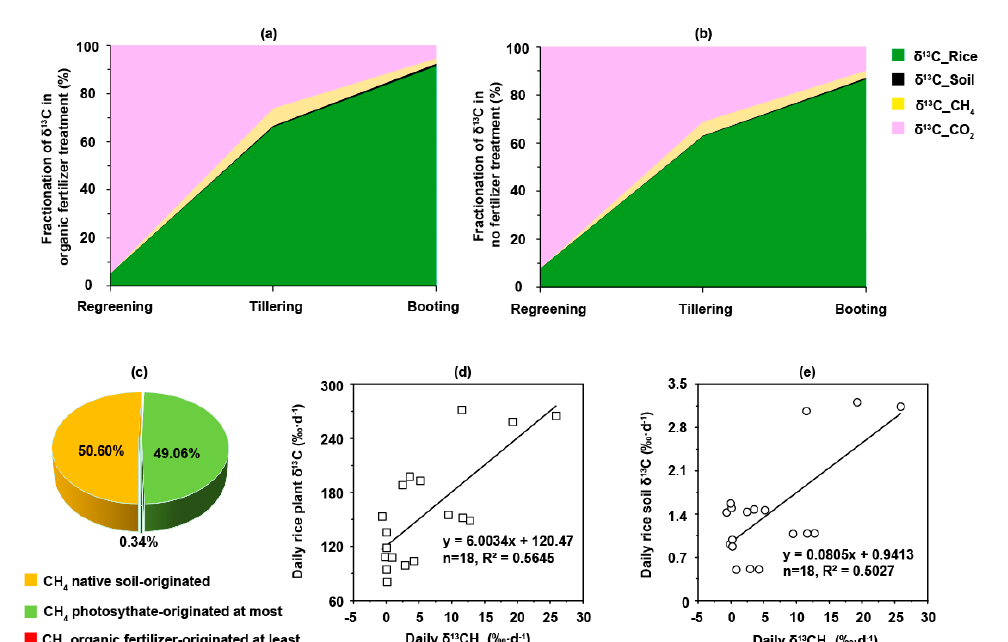
Figure 2. Relative abundance of δ 13 C from cultured rice soil. ( a , b ) are the distributions of δ 13 C in the CO 2 , CH 4 , rice plant and soil for the average values of organic fertilizer and no fertilizer treatment. ( c ) shows the total carbon sources for the CH 4 emissions in the cultivated rice soil. ( d , e ) are the linear regressions for the daily δ 13 CH 4 to the daily rice plant δ 13 C and soil δ 13 C. Meanwhile, CH 4 fluxes, δ 13 CH 4 and rice biomass are shown in Figure S1, CO 2 , CH 4 emissions and 13 C atom percentage (%) in Figure S2, and soil and rice plant δ 13 C in Figure S3. Results indicated that approximately 49.06% of the carbon in the CH 4 was derived from rice photosynthates. Therefore, the rest of the carbon sources would be approximately 50.95%, which should come from organic fertilizer or native soil. The average carbon and nitrogen of the organic manure was 23.05% and 2.07%. We knew that the pure nitrogen was applied at 300 kg · N · ha − 1 . By calculation, the carbon from the organic fertilizer was applied at 2.36 g in the soil. Alternatively, the soil total carbon and bulk density were 1.78% and 1.43 g · cm − 3 , respectively. The total amount of carbon in the topsoil (20 cm) was approximately 359.67 g. Therefore, the carbon ratio of the organic fertilizer and original soil would be 0.66%. Consequently, the carbon source for the CH 4 emissions derived from the organic fertilizers would be 0.34% at most, and 50.60% were from the soil at least. This was how we calculated the carbon sources of CH 4 in the rice soil after the organic fertilizer was applied.